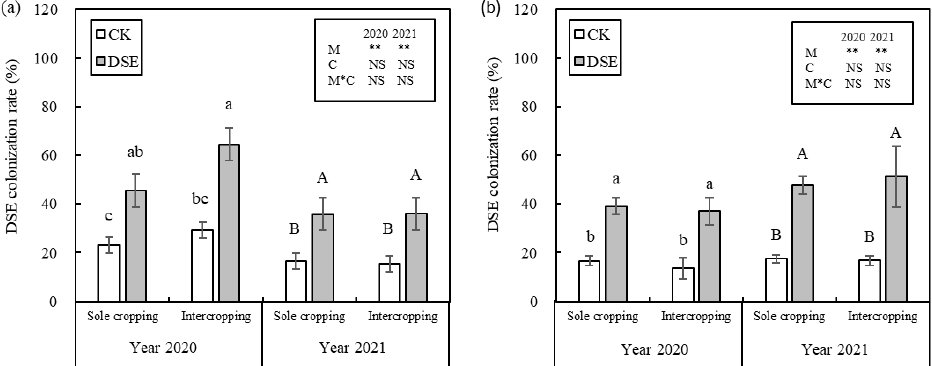
Figure 5. DSE colonization rates of buckwheat and alfalfa under different treatments. ( a ) DSE colonization rate in buckwheat; ( b ) DSE colonization rate in alfalfa. Different lowercase letters indicate a significant difference at the 5% level by LSD between different treatments in 2020. Different capital letters indicate a significant difference at the 5% level by LSD between different treatments in 2021. M, microbial treatment; C, cropping pattern; **, p < 0.01; NS, not significant.